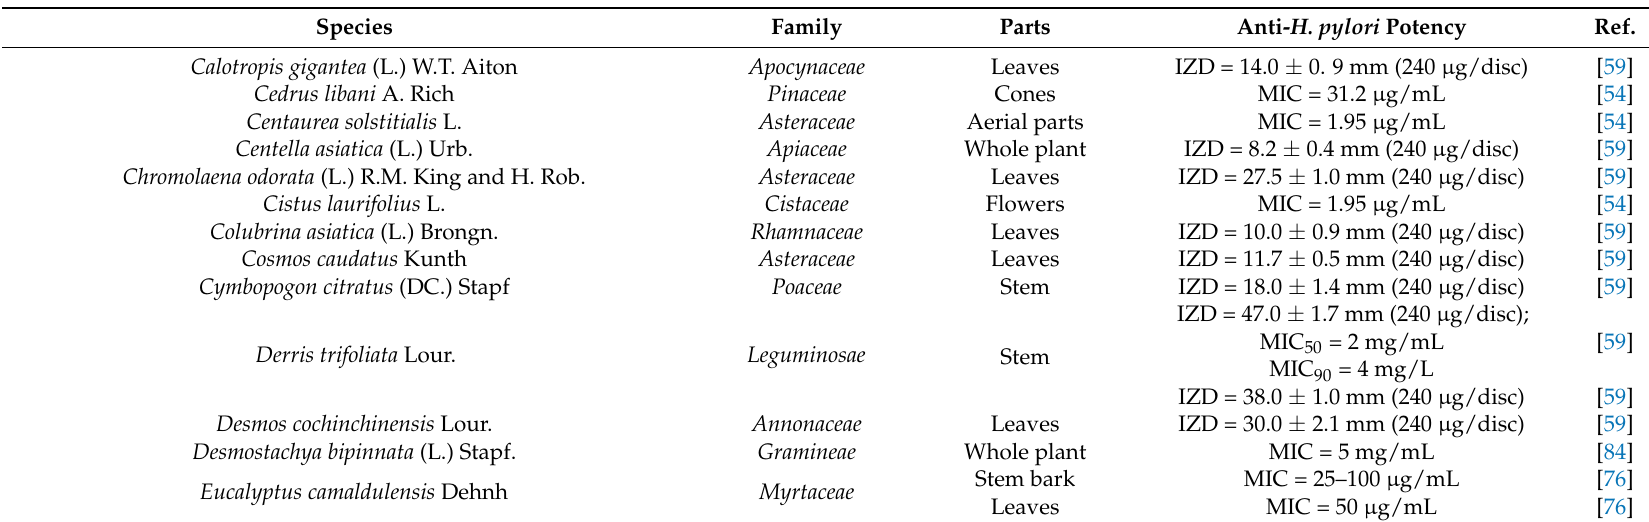
Table 6. Plant chloroform extracts with anti- H. pylori activity. Family Parts Anti- H. pylori Potency